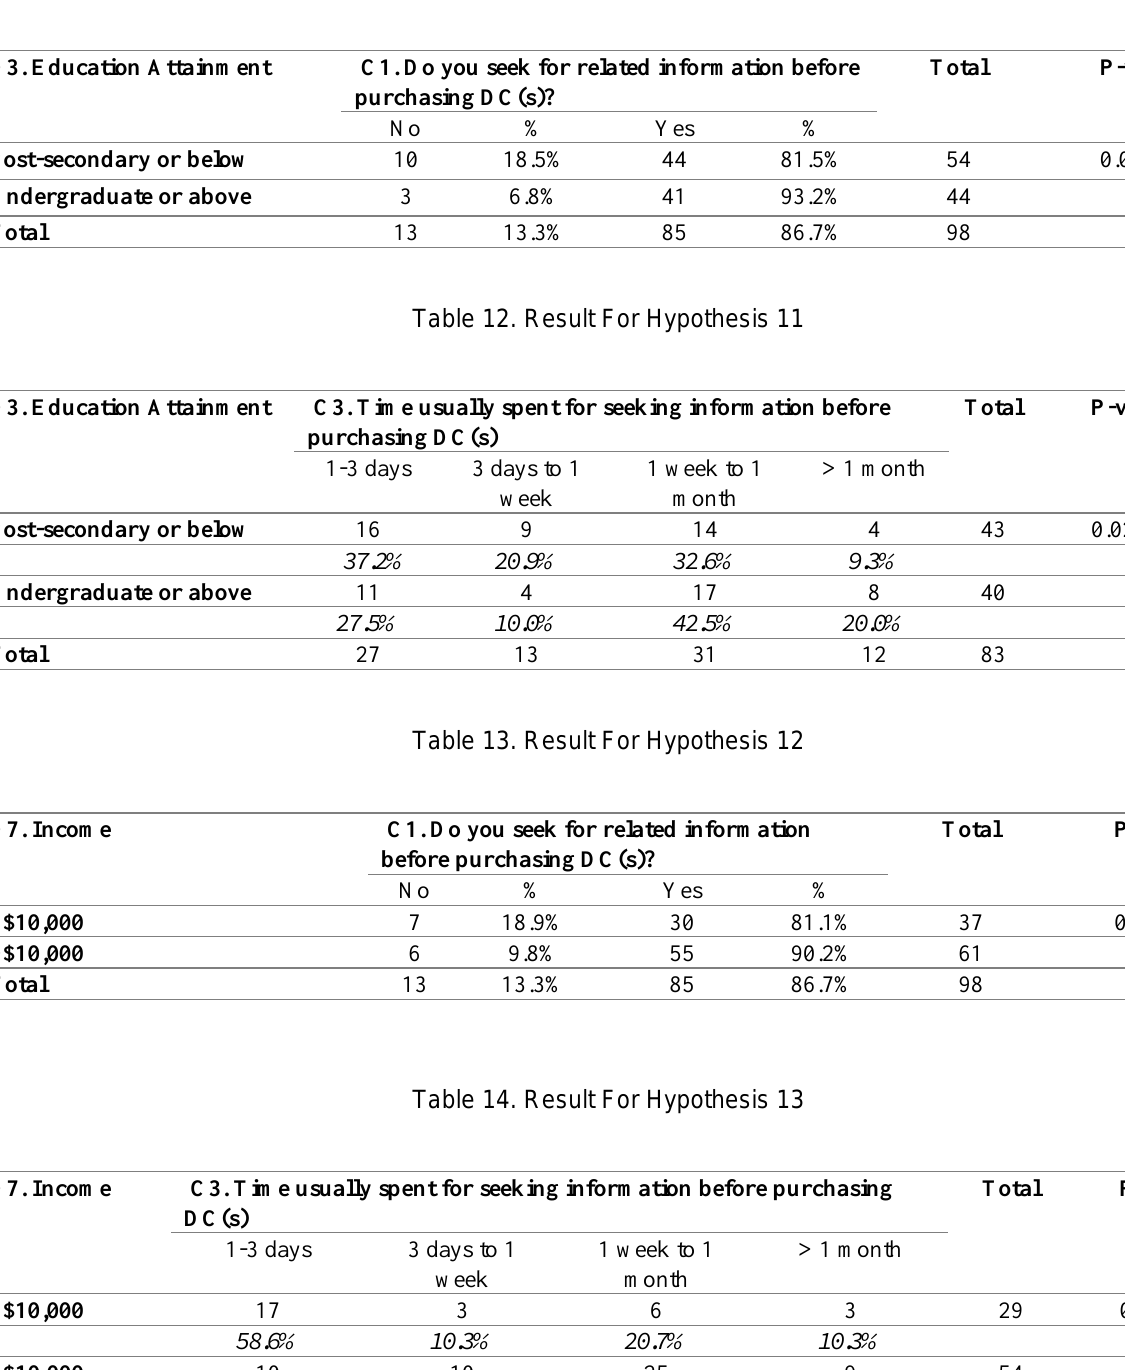
Table 11. Result For Hypothesis 10